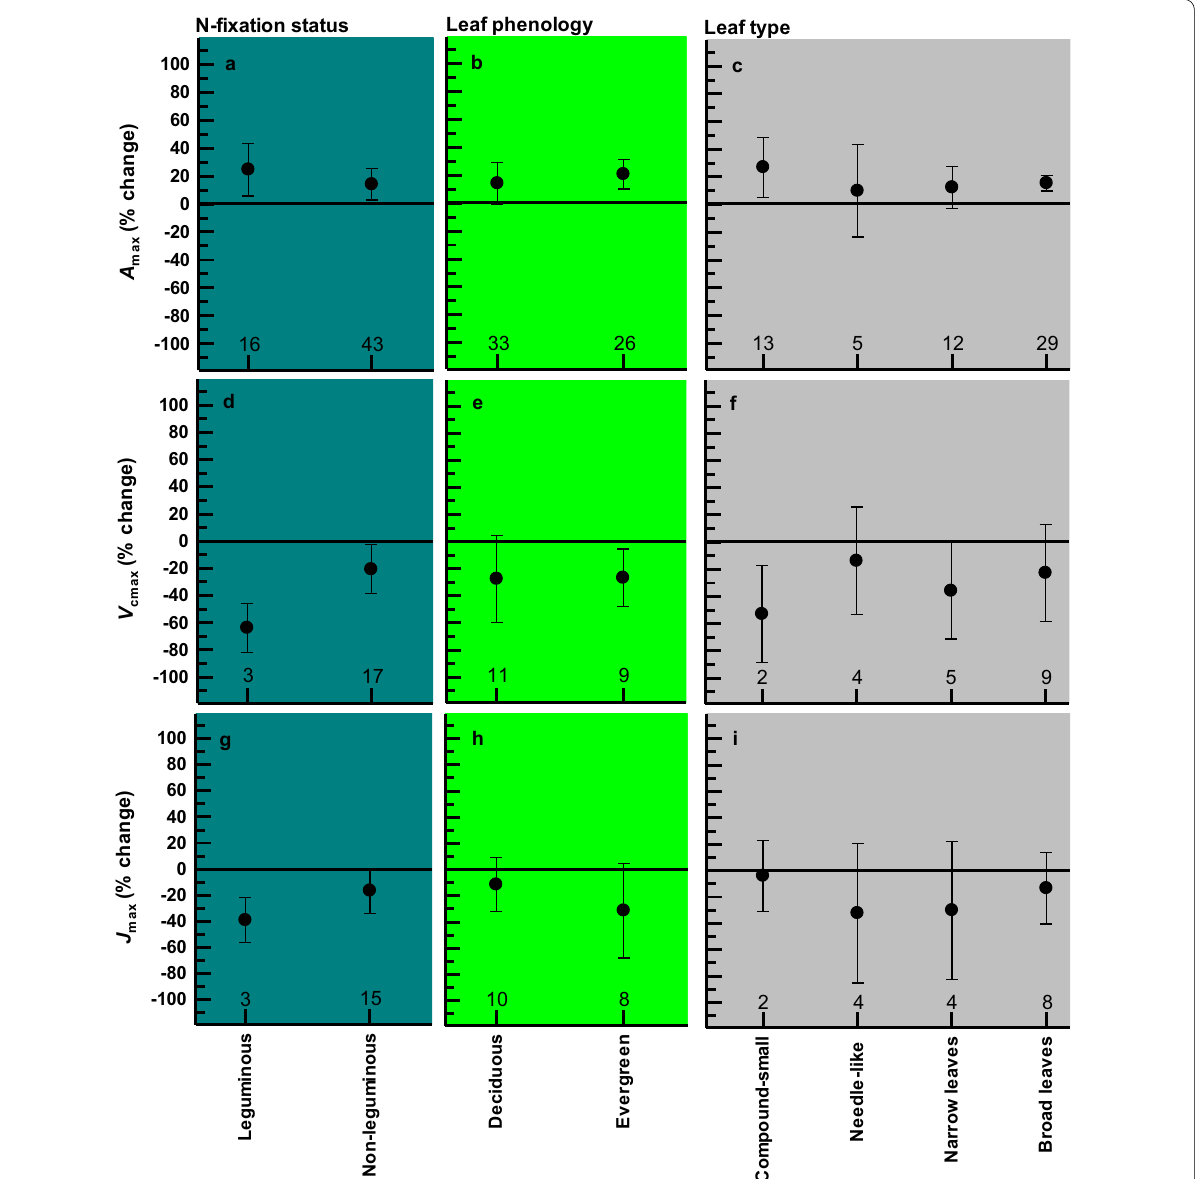
Fig. 8 Percentage change ( 95% CI) in photosynthetic characteristics ( A max , V cmax and J max ) of woody plants with different N-fixation ability ( a , d ± and g ), leaf phenology ( b , e and h ) and leaf types ( c , f and i ) grown at eCO 2 . The whiskers denote 95% CI and the circles denote mean percentage change. The numbers above the major ticks of the X -axis denote number of observations. Key to leaf types: Compound-small with small leaflets and Needle-like needle-like =